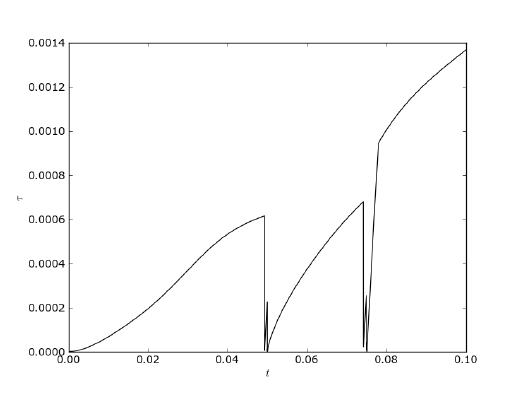
Figure 7. The time-history of the time step: u 0 ( x ) = 1.